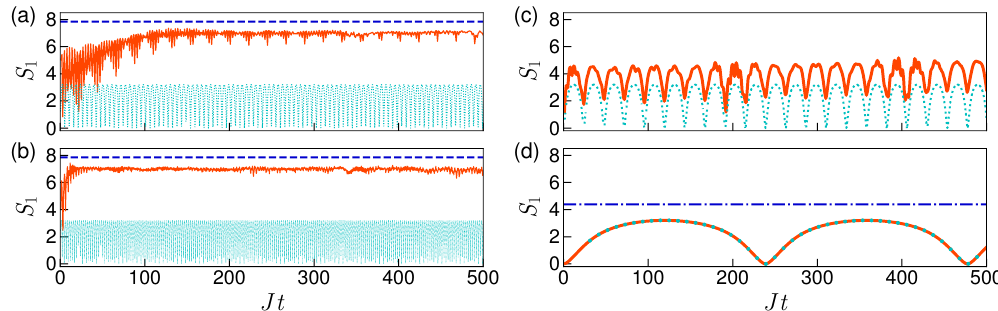
Figure 7: Entanglement dynamics. Dimensionless units are used. For all cases, N = 20 and J = 1, and the initial state is | 20,0,0 〉 . (a): UN / J = 0.02, (b): ( ρ ( t )) UN / J = 0.2, (c): UN / J = 2, and (d): UN / J = 20. The orange lines depict S 1 ( ˜ ρ ( t )) . The dashed blue lines (panels (a) and (b)) and the dotted cyan lines depict S 1 depict the maximum entanglement, while the dot-dashed line (panel (d)) represents the maximum entanglement that can be generated by the effective Hamiltonian